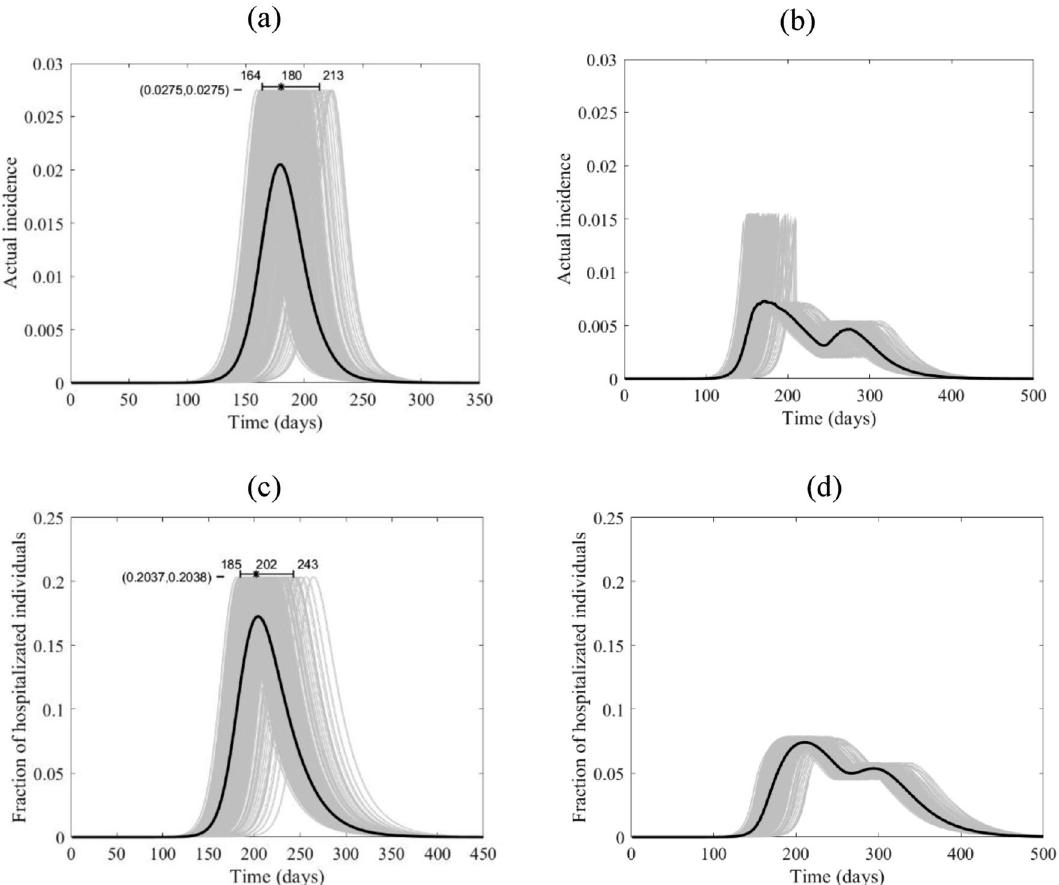
Figure 6. The course of the actual incidence ( a ) and ( b ), and fraction of hospitalized COVID-19 infected individuals ( c ) and ( d ) in China with no control measure (left panel) and with starting lockdown (right panel) of 15 days before the peak and that lasts for 90 days. They are calculated at R 0 = 6.47 , with initially one adult mild infection. The grey curves are resulting from the stochastic model simulations and the black curve is the mean of those grey curves. They are all normalized by the population